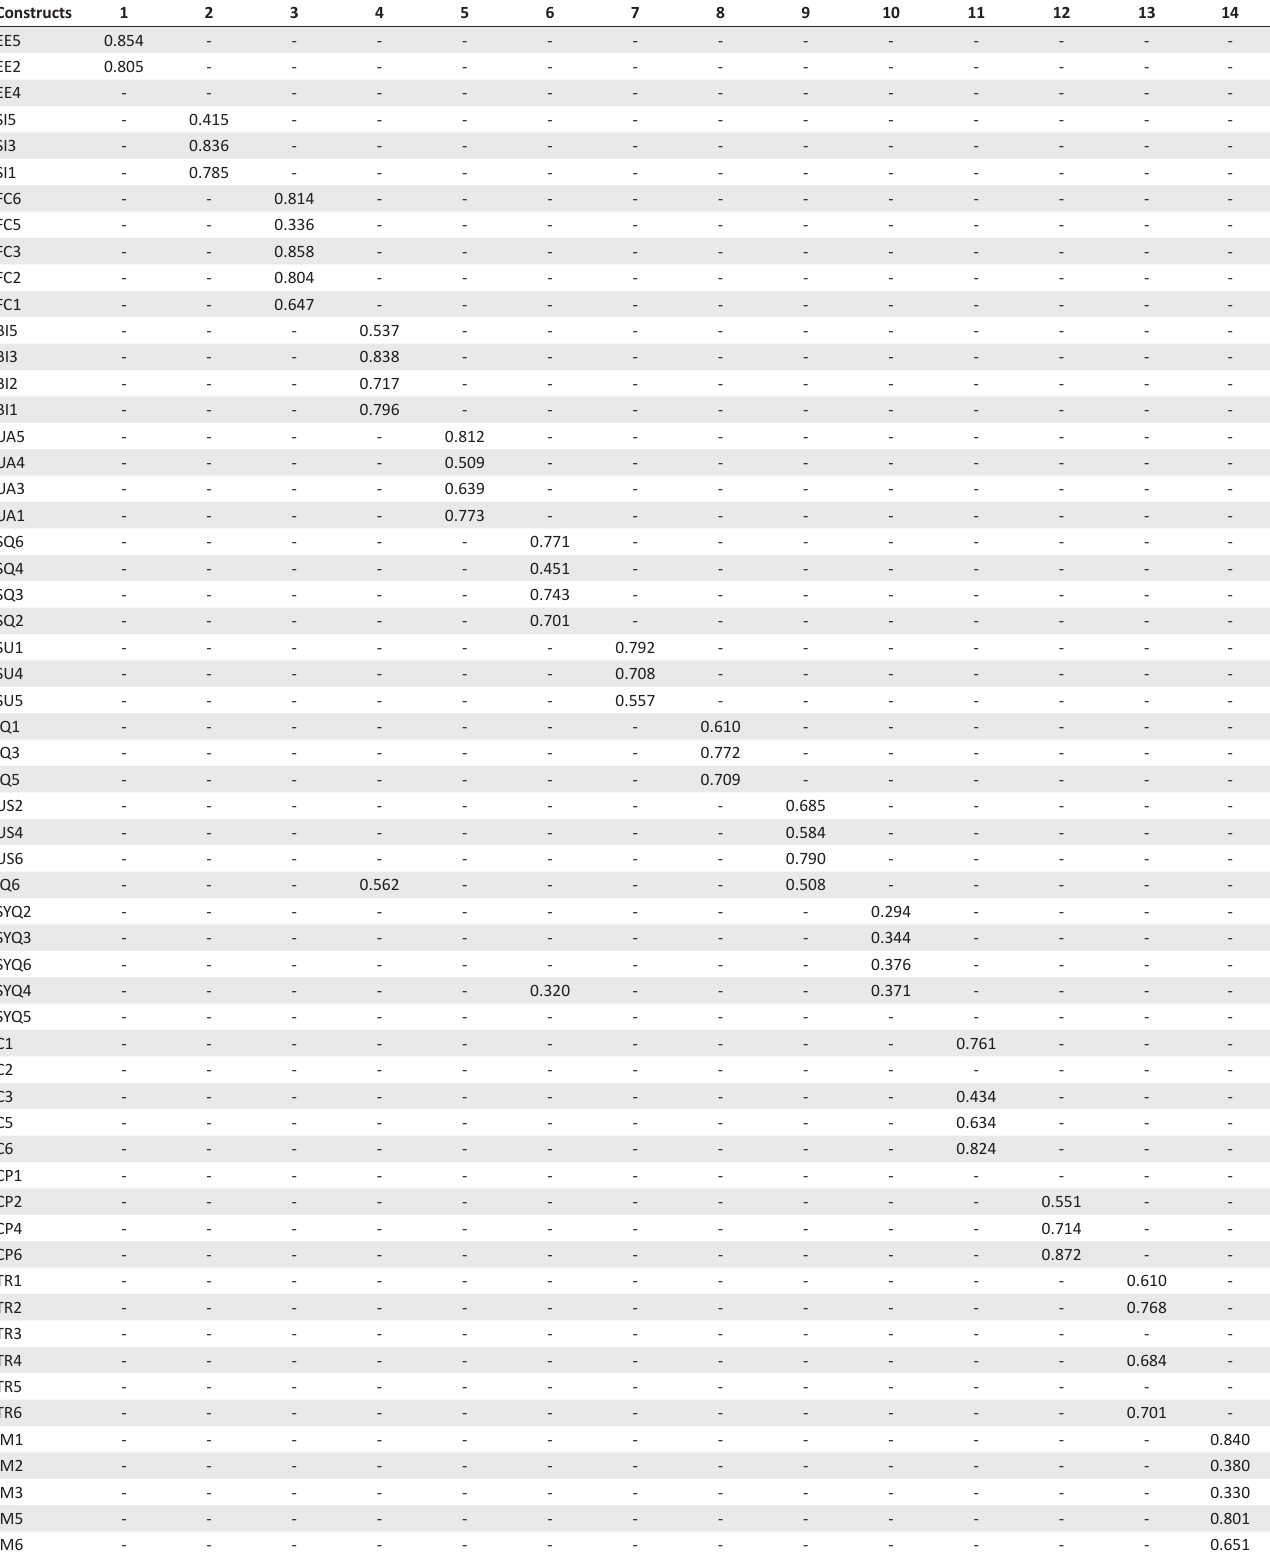
TABLE 4: The 14 factor pattern matrix.